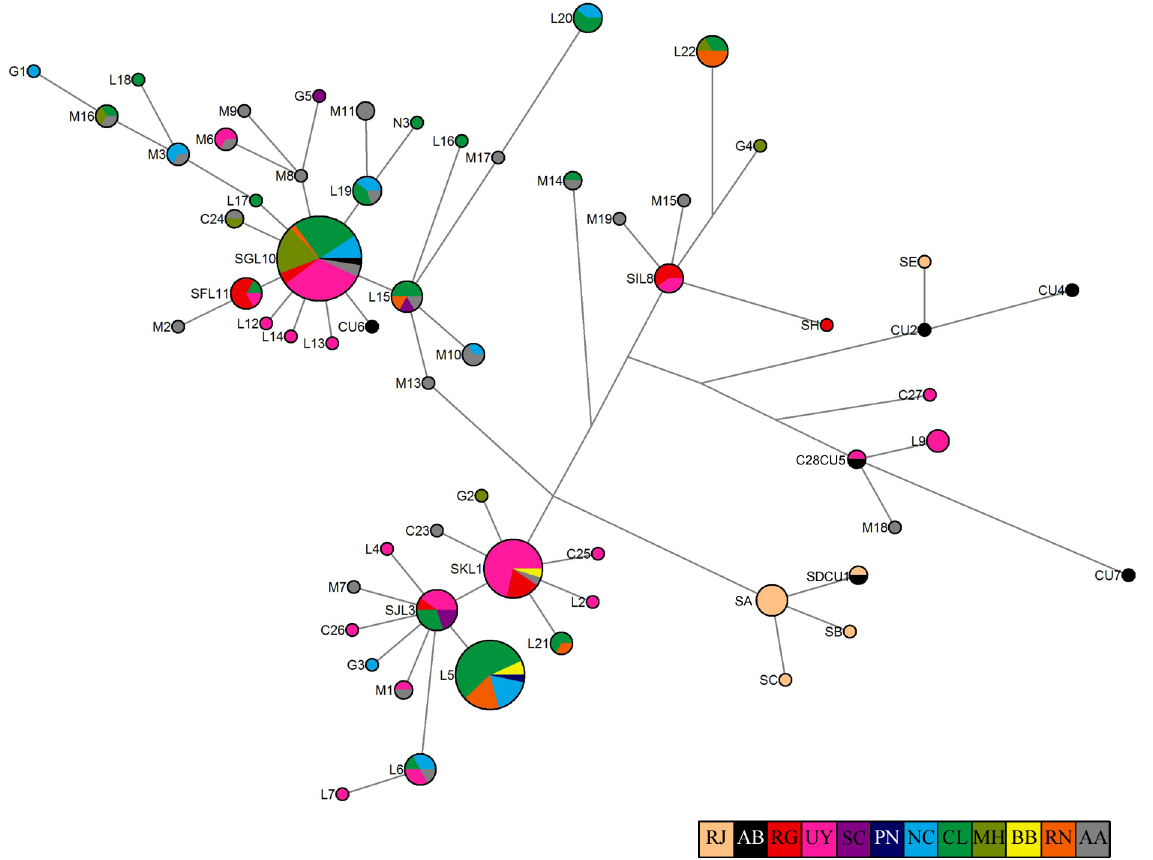
Fig 2. Median-joining network based on the mtDNA control region haplotypes of franciscana dolphins. The size of the circle is proportional to frequency. Branch length reflects the number of mutations separating any two haplotypes. AA and AB: haplotypes with unknown exact sampling site and/or frequency, collected from Argentina [3,33] and Brazil [34], respectively. The frequency for AA and AB was set to one individual. RJ: Rio de Janeiro; RG: Rio Grande do Sul; UY: Uruguay; SCL: San Clemente del Tuyú; PN: Pinamar; NC: Necochea; CL: Claromecó; MH: Monte Hermoso; BB: Bahía Blanca; RN: Río Negro. Haplotype SJ-L3-M4-M5-M12 is shown with a shorter nomenclature, SJL3.